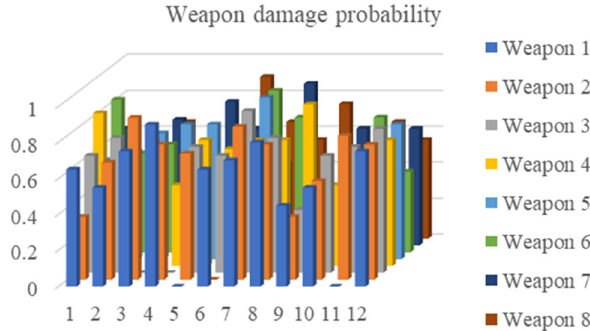
Fig. 6 The histogram of the weapon damage probability for case